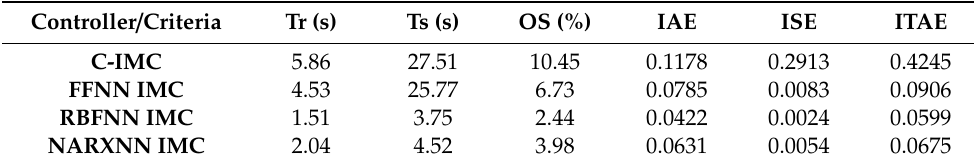
Figure 15. Input–output step responses performance; ( a ) voltage, ( b ) flux, ( c ) TMP. Table 4. Step response performance evaluations.